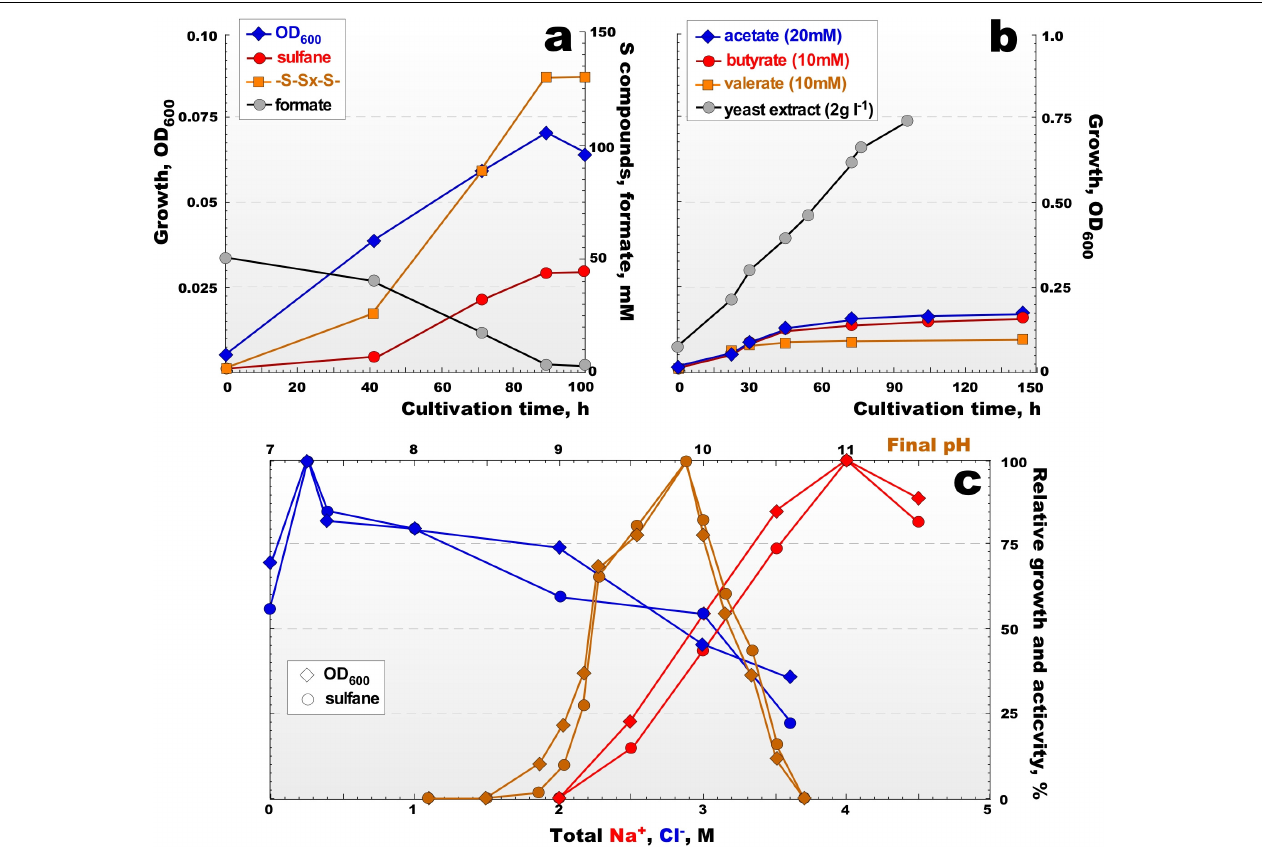
FIGURE 3 | Growth kinetics and sulfidogenic activity of strain AArc1 at 4.0 M Na + , pH 9.5 and 37 ◦ C. (a) Anaerobic growth with formate as e -donor, elemental sulfur as e -acceptor and acetate 1 mM as carbon source. (b) Aerobic growth on acetate, butyrate, valerate and yeast extract. (c) Influence of pH at 4 M total Na + (orange lines), of salinity at pH 9.5 (as total Na + , red lines) and of Cl − at 4 M total Na + and at pH 9.5 (blue lines) on anaerobic growth with formate + sulfur. The data are mean values from 2 replicate